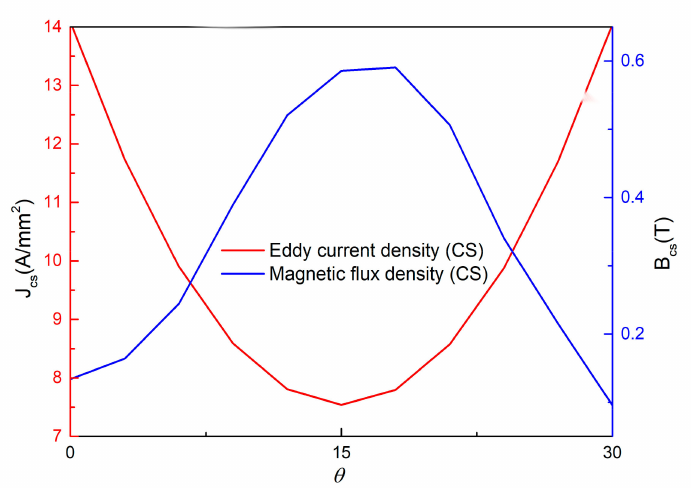
Figure 9. The curves for depicting the distributions on the